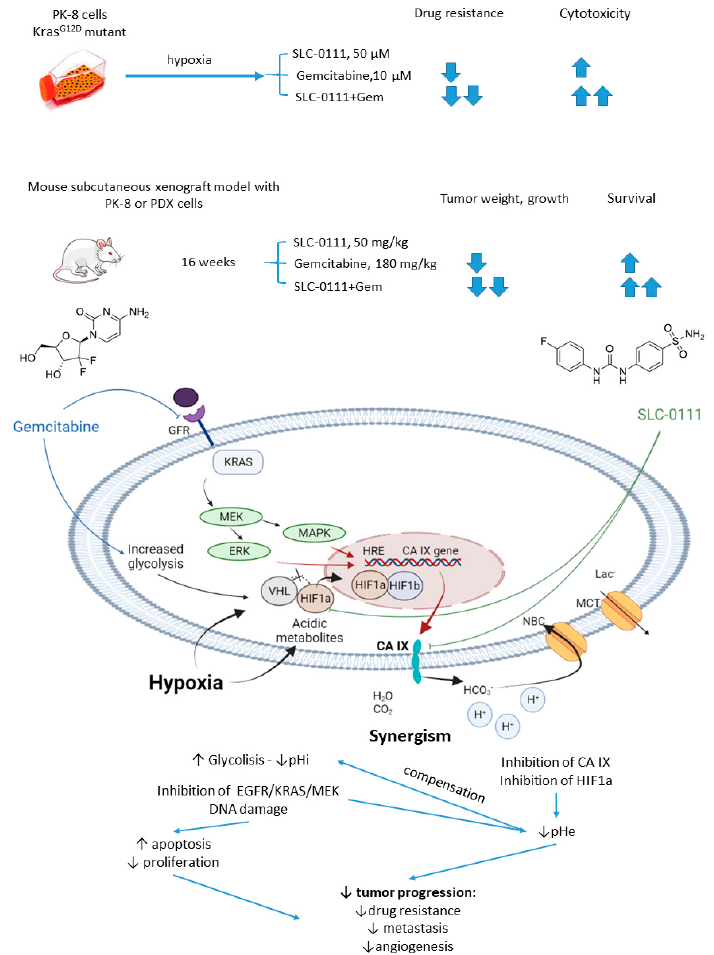
Figure 12. Graphical outline of the study on SLC-0111+gemcitabine combination reported by McDonald et al., and summary on the hypothesized molecular interactions resulting in synergistic action of the drugs [71].